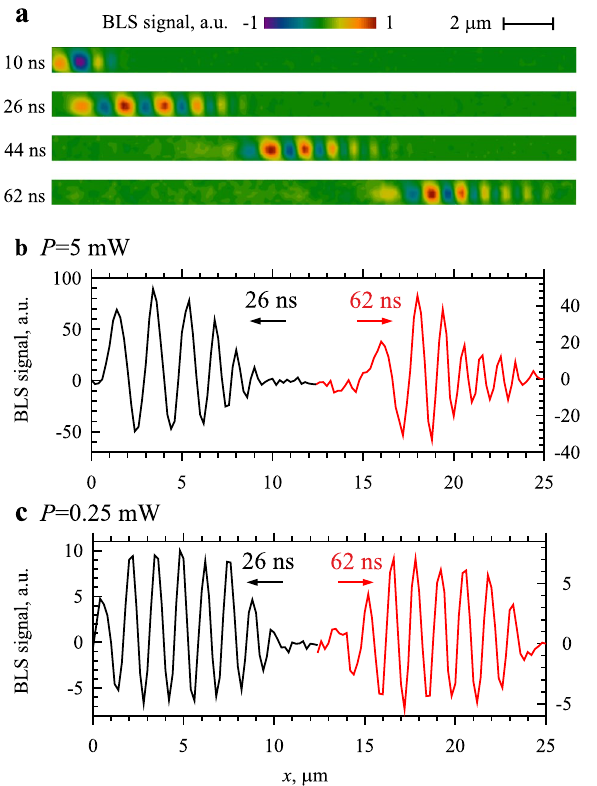
Figure 2. Propagation of nonlinear spin-wave pulses. ( a ) Representative two-dimensional BLS maps visualizing the propagation of the spin-wave pulse. The maps are recorded at P = 5 mW and f = 4.1 GHz for different temporal delays with respect to the start of the microwave pulse applied to the antenna, as labelled. ( b ) and ( c ) One-dimensional sections of the maps along the waveguide axis for two delays ( t = 26 and 62 ns) corresponding to the initial and the final stage of the pulse propagation, recorded at P = 5 mW ( b ) and 0.25 mW ( c